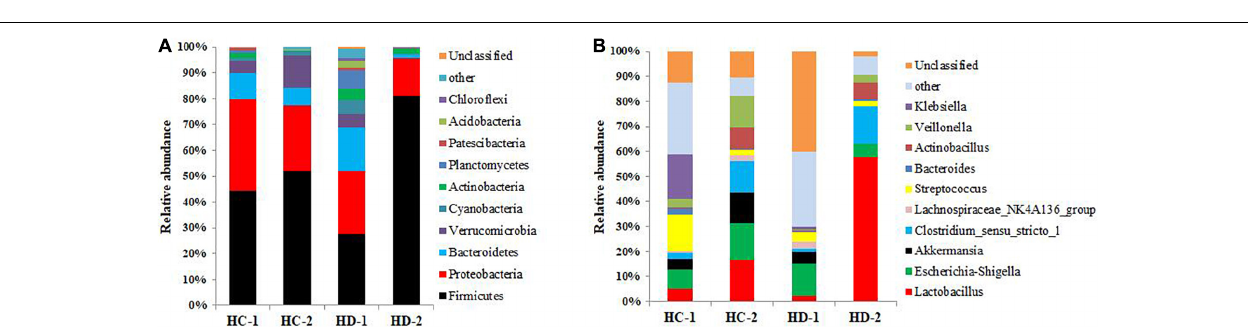
FIGURE 2 | Bacterial community composition of ileal digesta. (A) Phylum level; (B) genus level. HC-1: bacterial composition of ileal digesta sampled from Hoxa1 − / − neonatal piglets delivered by sows administered with ATRA, HC-2: bacterial composition of ileal digesta sampled from non-Hoxa1 − / − neonatal piglets delivered by sows administered with ATRA, HD-1: bacterial composition of ileal digesta sampled from Hoxa1 − / − neonatal piglets delivered by sows administered without ATRA, HD-2: bacterial composition of ileal digesta sampled from non-Hoxa1 − / − neonatal piglets delivered by sows administered without ATRA.